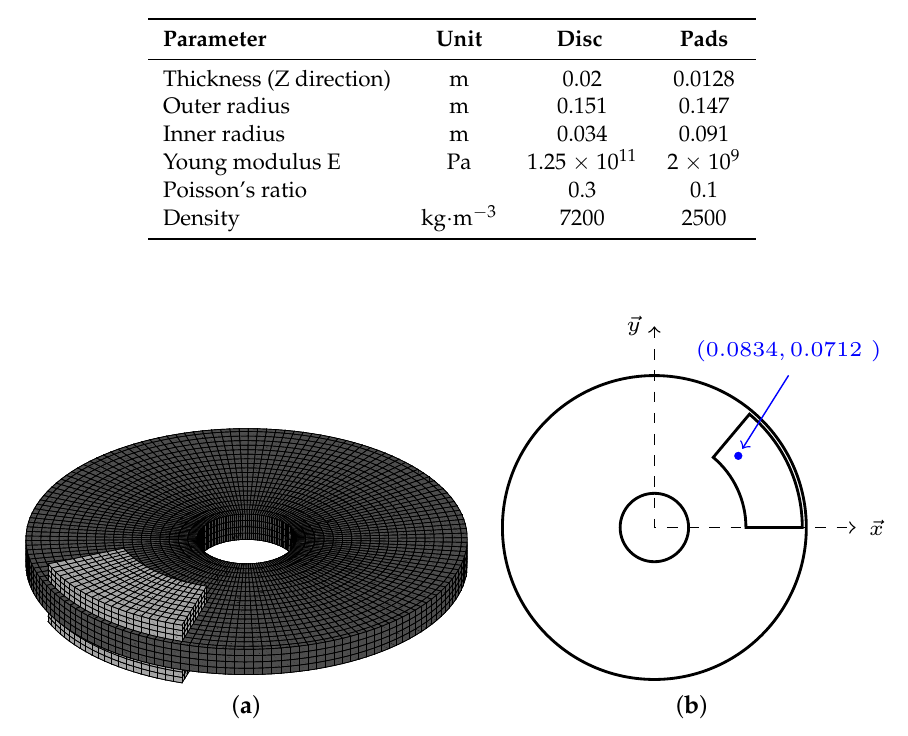
Table 1. Model parameters.